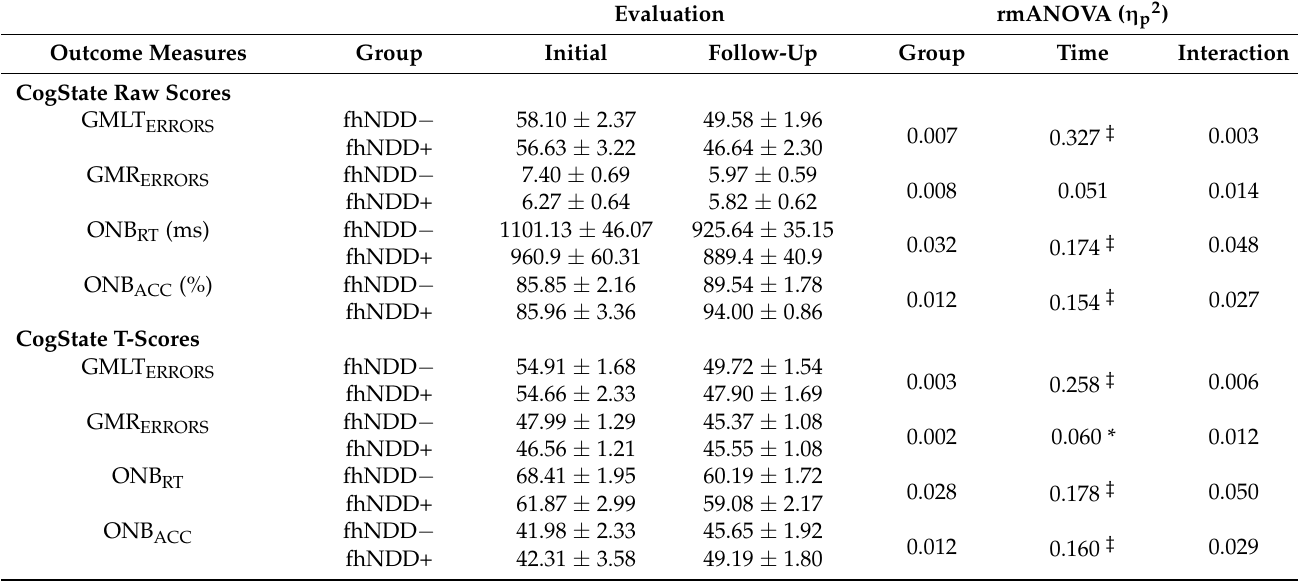
Table 5. Descriptive statistics for CogState measures at each